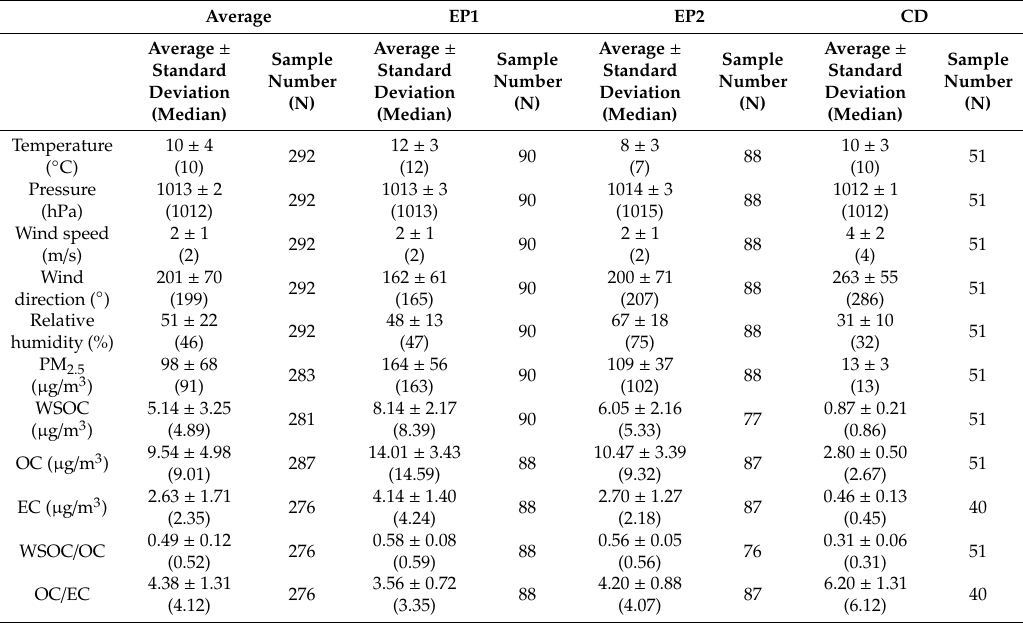
Table 1. Summary of mass concentrations of di ff erent carbonaceous components and meteorological conditions during the study period. OC: Organic carbon, WSOC: water-soluble organic carbon, EC: elemental carbon. EP1 and EP2: two pollution episodes, CD: clean day.